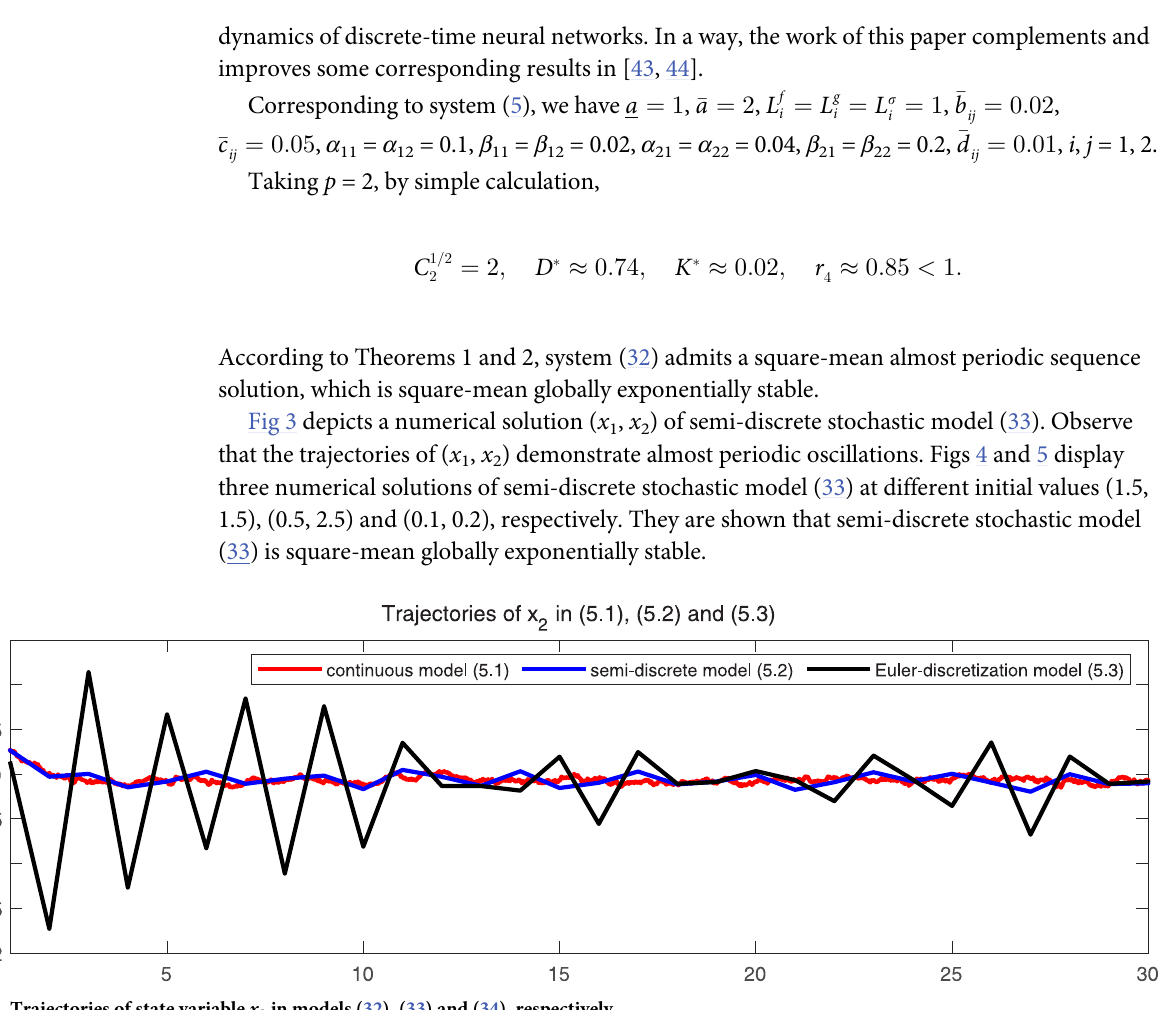
Fig 2. Trajectories of state variable x 2 in models (32), (33) and (34), respectively.